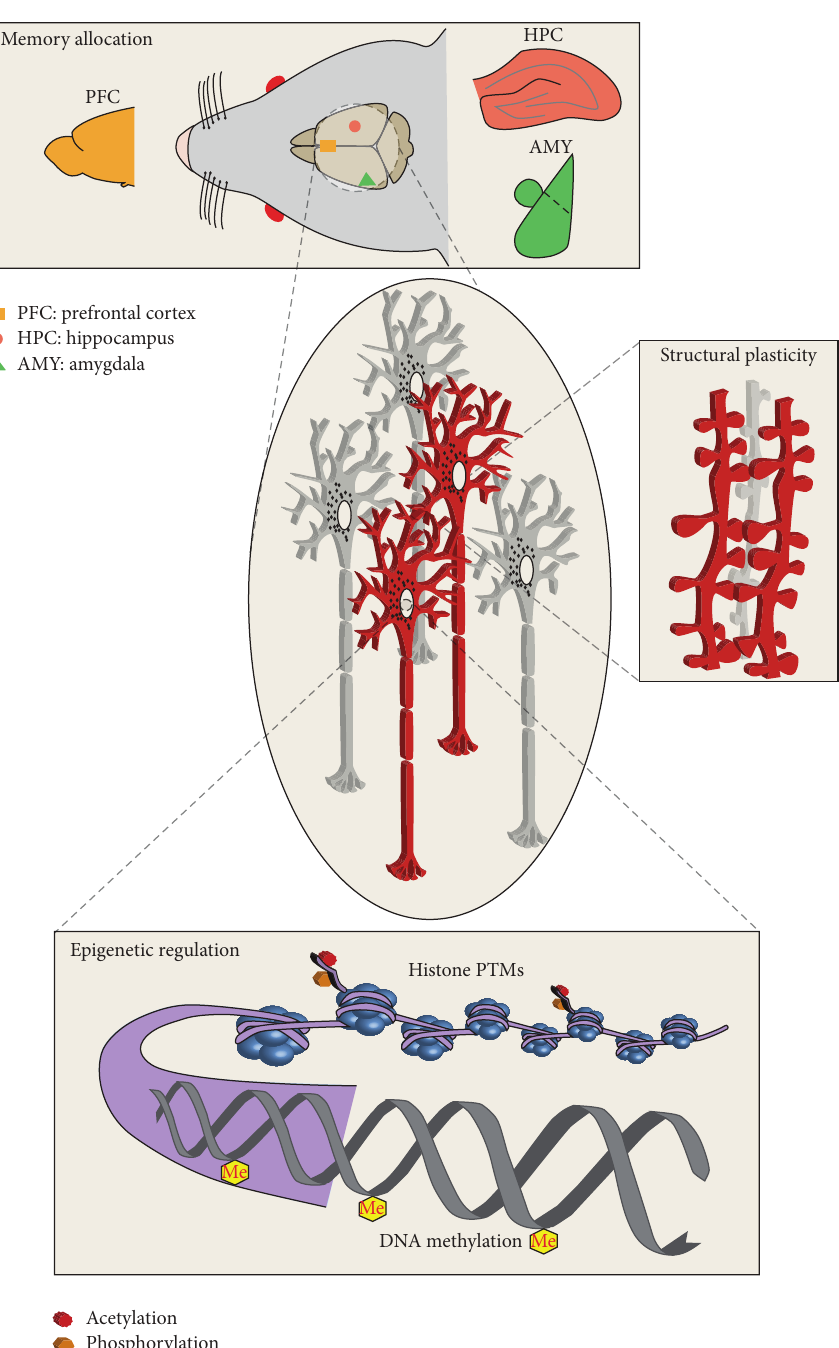
Figure 1: Schematic illustrating three essential mechanisms that might contribute to remote memory storage and thus memory endurance in the (rodent) brain, which are discussed in this review. First, during memory allocation, learning induces the activity of a specific subpopulation of cells—likely spread across different brain areas—which will become recruited into the memory trace. The amygdala (AMY), the hippocampus (HPC), and the prefrontal cortex (PFC) are known to be activated during memory allocation (for details see text). Second, in cells allocated to a specific memory—also known as the memory engram [1–3]—structural changes at the level of dendritic spines have been demonstrated by several studies. These changes are exclusive to the cells of the memory trace or engram (red) but not observed in other cells (grey) [53]. Third, memory engram cells are also likely to be characterized by epigenetic changes, such as posttranslational modifications (PTMs) on histone proteins, and methylation of the DNA, the core chromatin constituents. Note, however, that such engram- specific engagement of epigenetic mechanisms remains to be experimentally